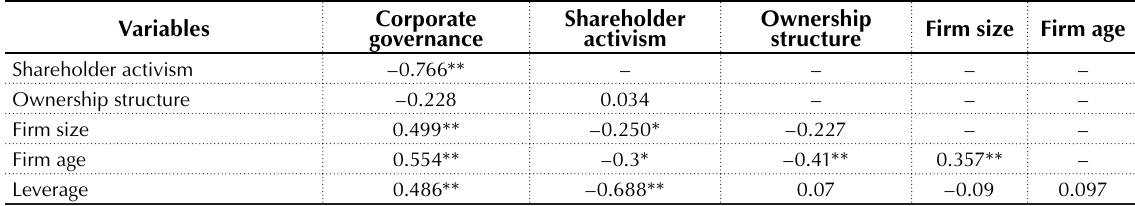
Table 5. Pearson correlation of shareholder activism scores with scores of corporate governance and control variables